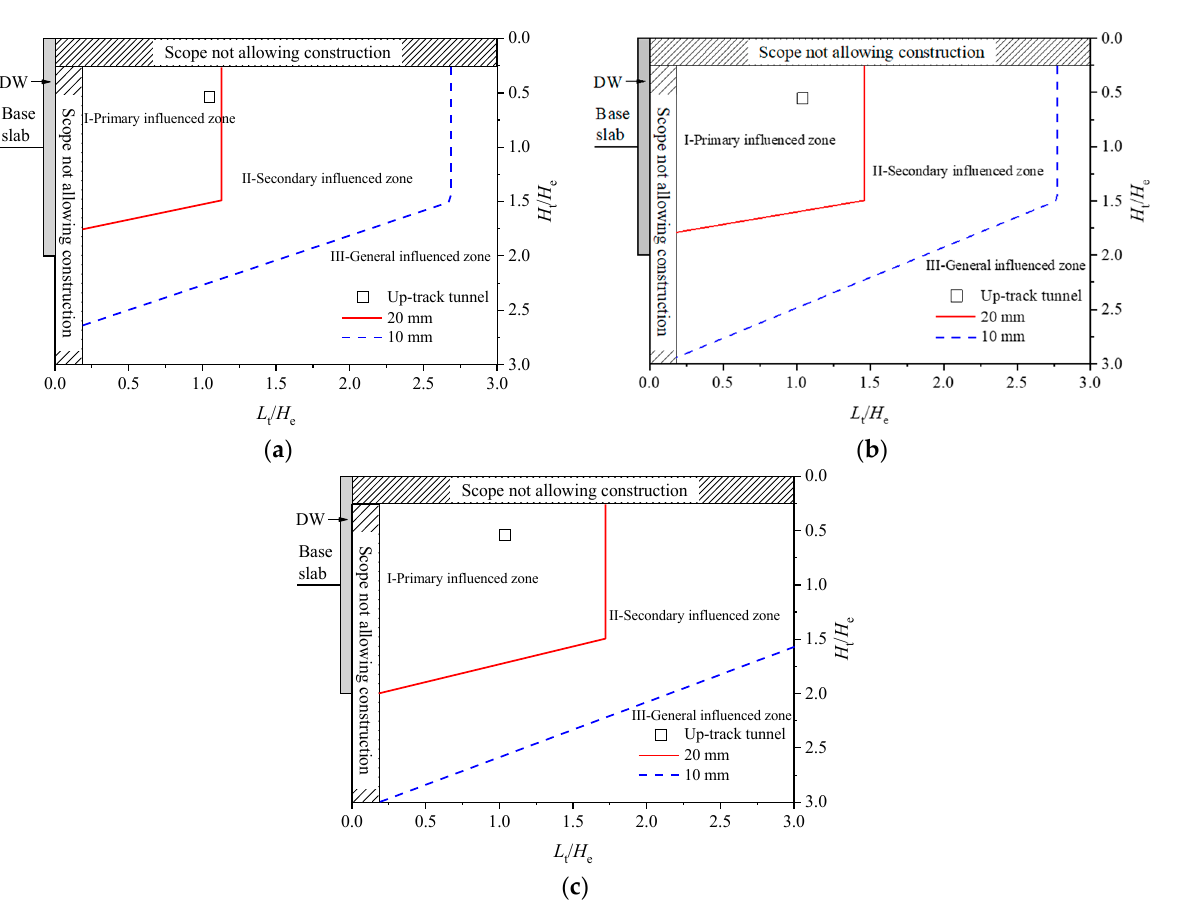
Figure 17. Influenced zones of deep excavation in tower building area: ( a ) H e = 34 m, δ hm = 0.18% H e ; ( b ) H e = 34 m, δ hm = 0.3% H e ; ( c ) H e = 34 m, δ hm = 0.7% H e .